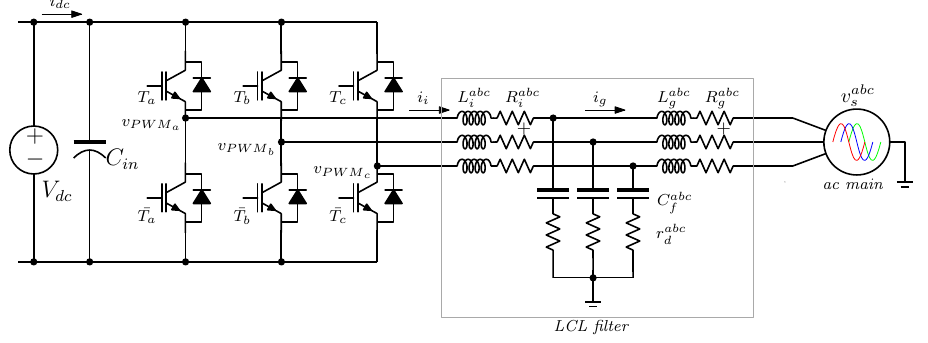
Figure 2. Three-phase inverter